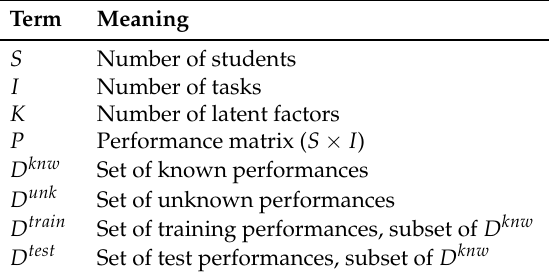
Table 1. Notation in the PSP problem.